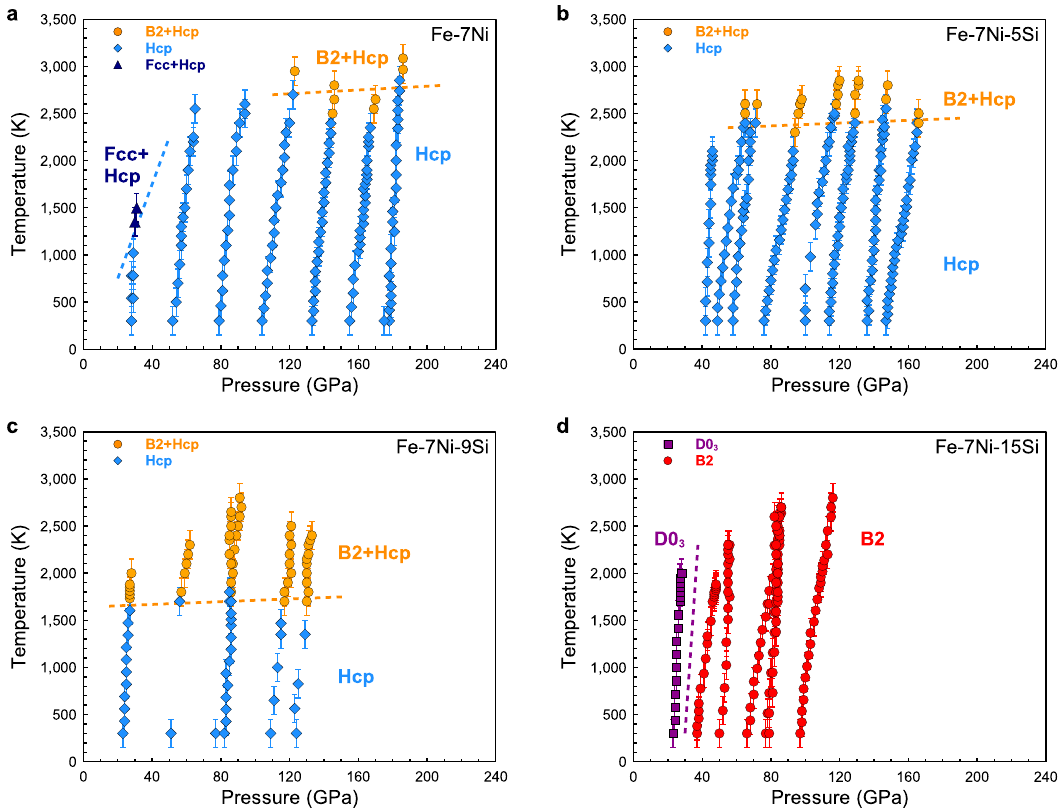
Fig. 2 Pressure – temperature phase diagrams in the Fe – Ni/Fe – Ni – Si system. a Fe – 7Ni, b Fe – 7Ni – 5Si, c Fe – 7Ni – 9Si, and d Fe – 7Ni – 15Si at high pressure and temperature. Pressure errors are ±2 GPa and temperature errors are ±150